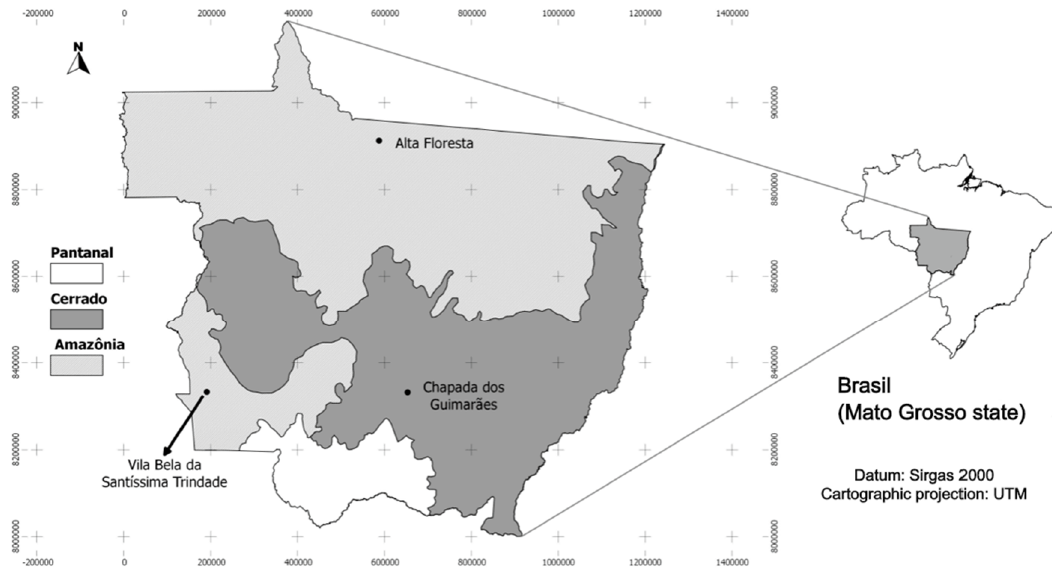
Figure 4. Biomes in Mato Grosso State and the locations of the study sites in the respective counties. (Instituto Brasileiro de Geografia e Estatıstica - IBGE).